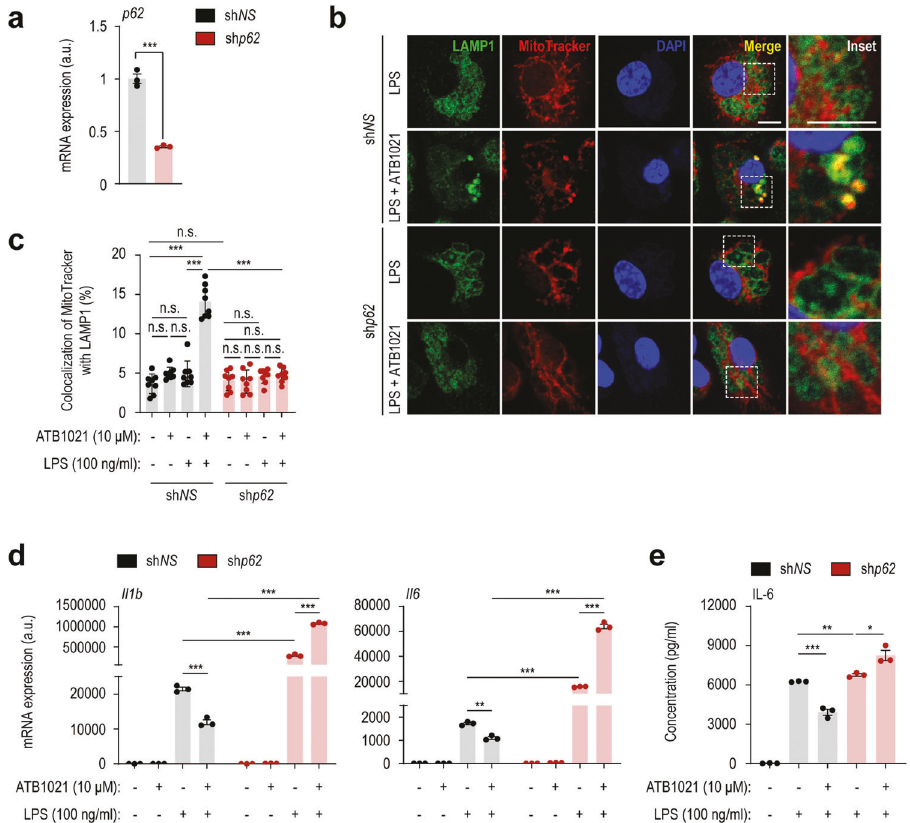
Fig. 6 p62 ligand-mediated mitophagy activation and inhibition of LPS-induced in fl ammatory responses in macrophages is dependent on p62. a p62 mRNA level in macrophages transduced with control (sh NS ) or p62 -speci fi c shRNA (sh p62 ) ( n = 3). b Control or p62 -silenced PMs were treated with vehicle or ATB1021 (10 μ M) for 1 h and stimulated with LPS (100 ng/mL) for 2 h; they were then stained with anti-LAMP1 antibody (green), MitoTracker (red), and DAPI (blue). Representative images are shown. Scale bar, 2 μ m. The inset shows the cropped part of the merged images (scale bar, 2 μ m). c , d sh NS- or sh p62- transduced macrophages were treated with vehicle or ATB1021 (10 μ M) for 1 h and stimulated with LPS (100 ng/mL) for 6 h prior to quantitative PCR analysis of Il1b and Il6 ( d ) or 18 h prior to ELISA analysis of IL-6 in